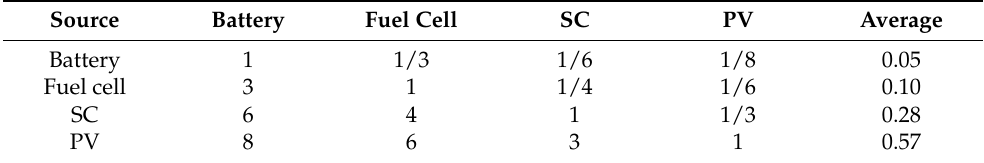
Table 2. Cost of usage relative